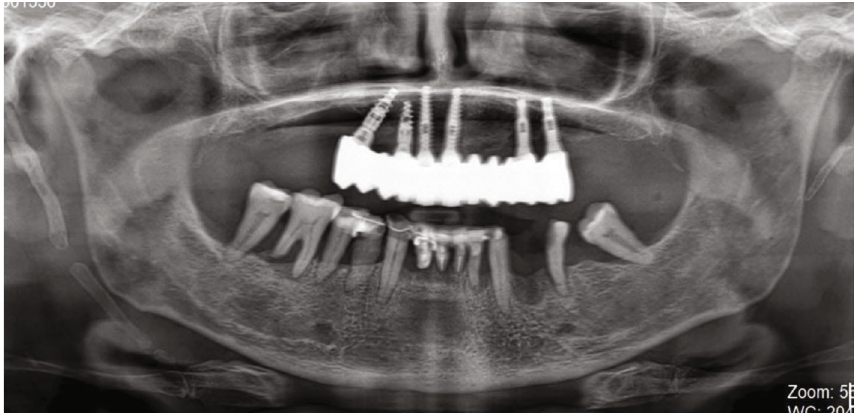
Figure 9: Orthopantomography performed in 2021.